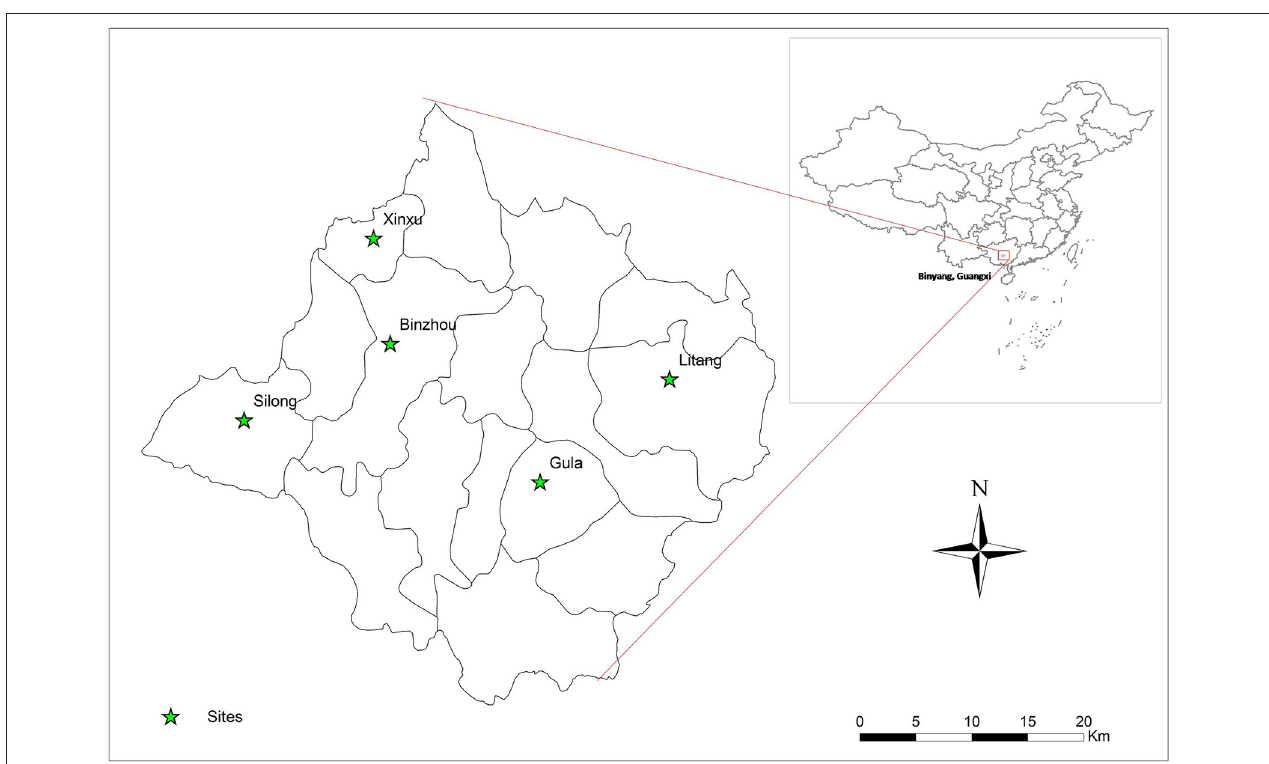
FIGURE 1 | Surveyed sites: five villages in Binyang,